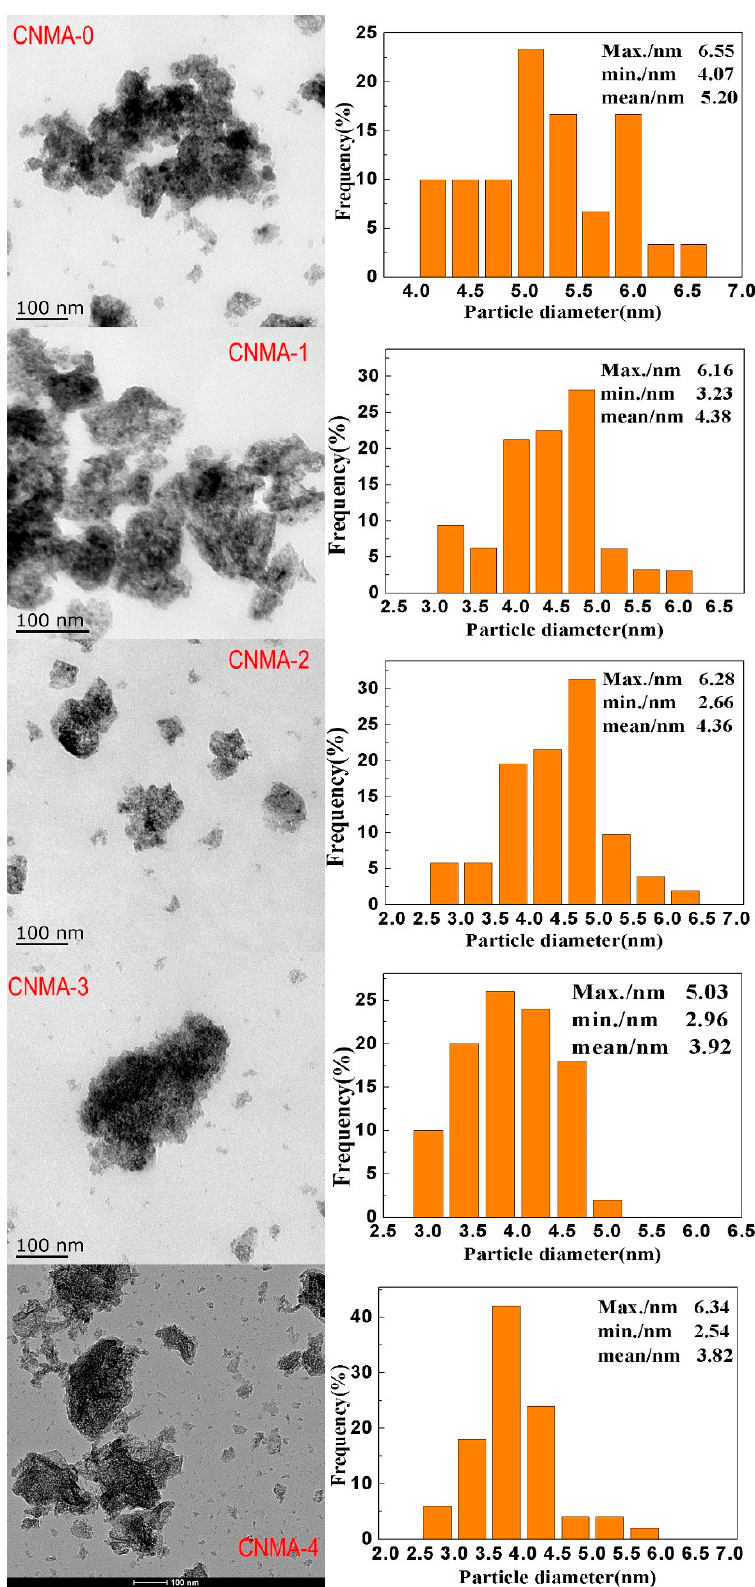
Figure 4. TEM images (left) and corresponding Cu particle size distribution (right) of the catalysts reduced with H 2 at 300 °C for 2 h.